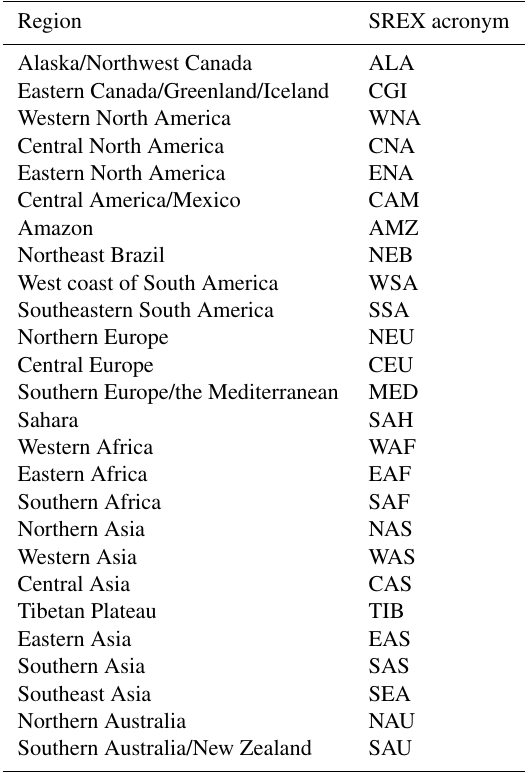
Table 2. List of acronyms for all 26 SREX regions (Seneviratne et al.,